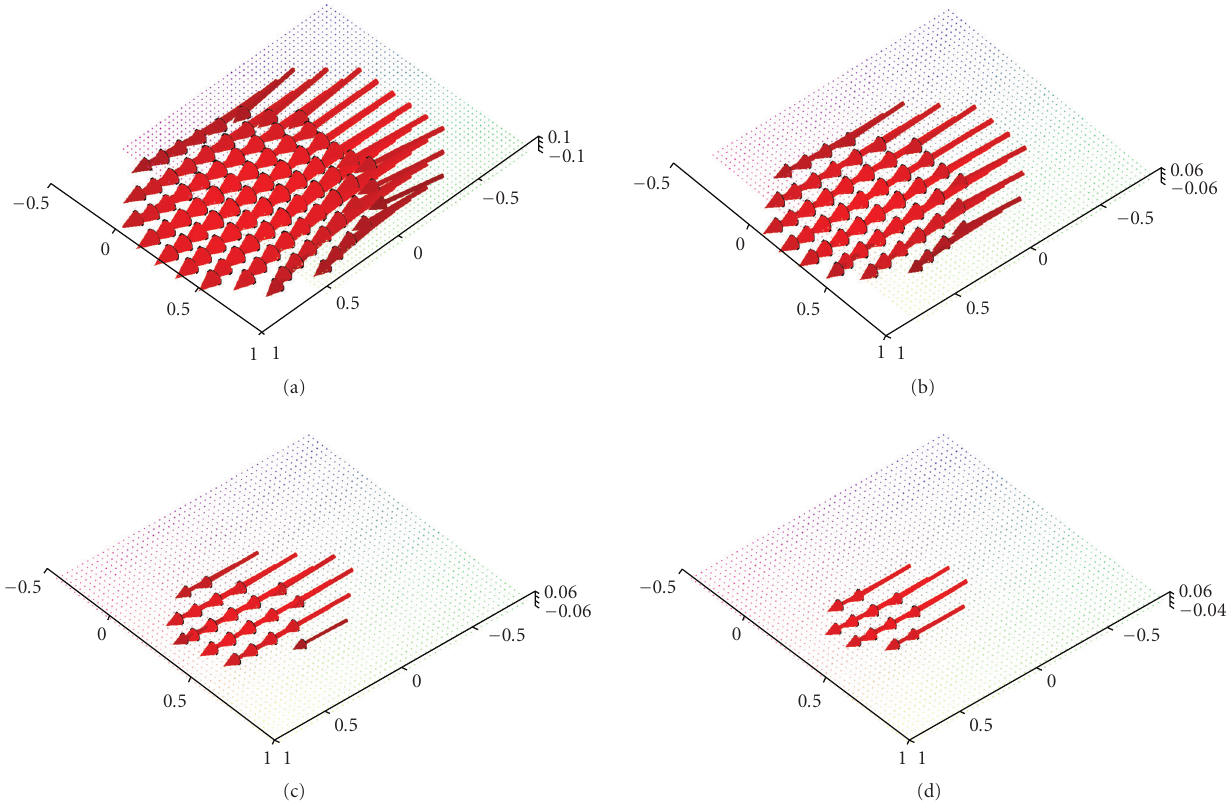
Figure 9: Reconstruction of the vector field f ( x ) = (1,0,0) (cid:9) with the described algorithm for γ = 0 . 0075 using exact, simulated data D 1 f . (a),(b) The planes { x 3 = 0 . 5 } and { x 3 = 0 . 75 } . (c),(d) The planes { x 3 = 0 . 9 } and { x 3 = 0 . 95 } .